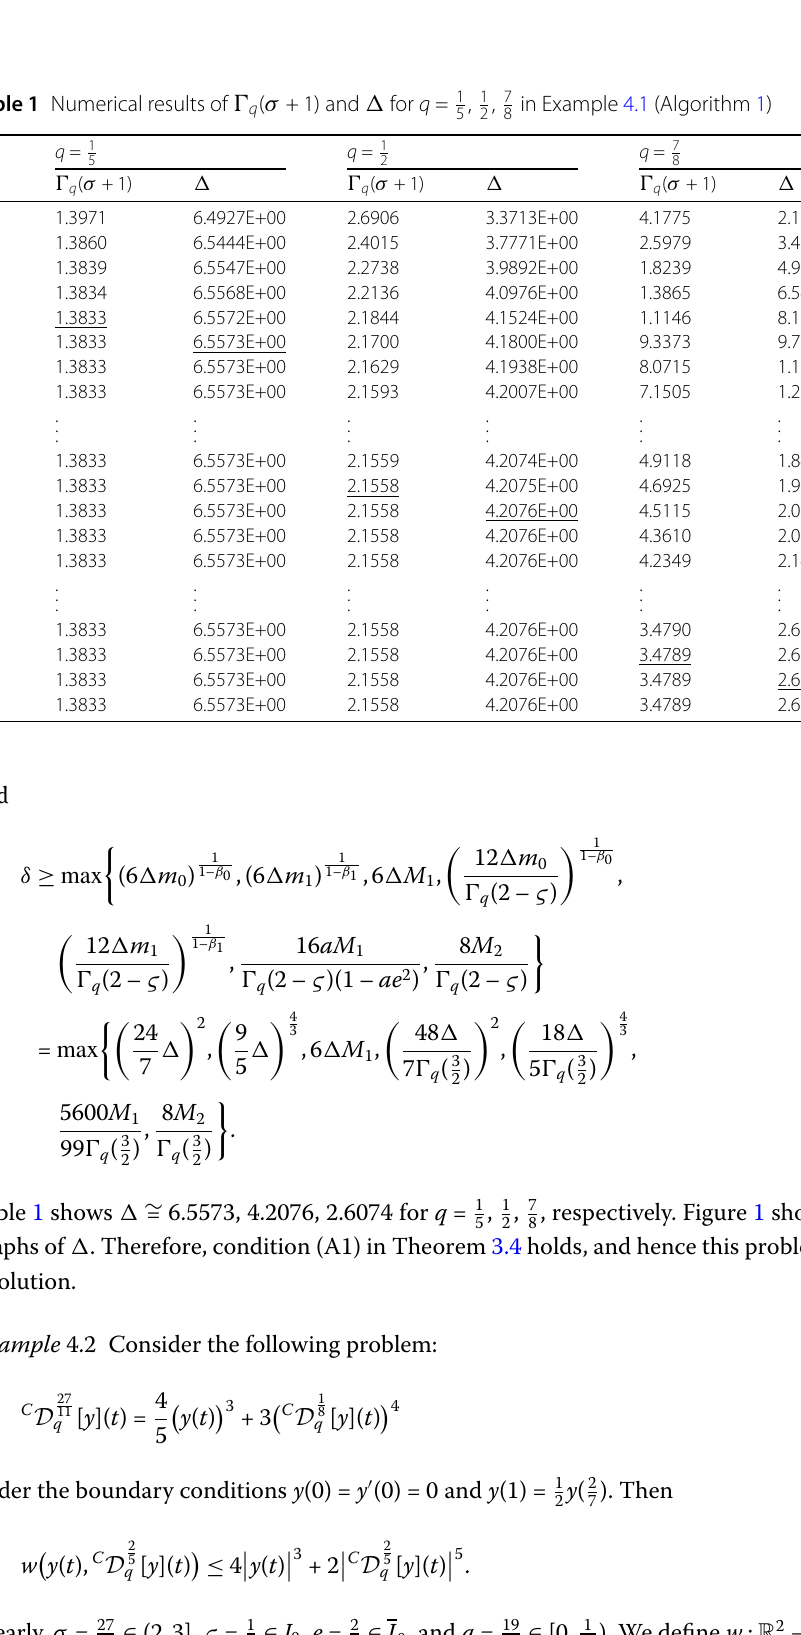
Table 1 Numerical results of (cid:7) q ( σ + 1) and (cid:14) for q = 1